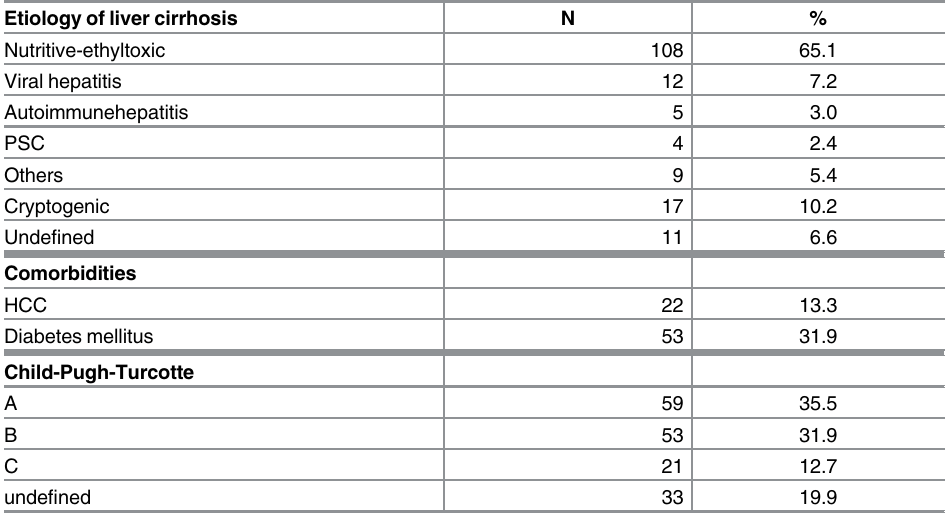
Table 2. Description of liver disease etiologies, comorbidities and Child-Pugh-Turcotte classification in numbers and percentage in the analyzed population (N = 166).